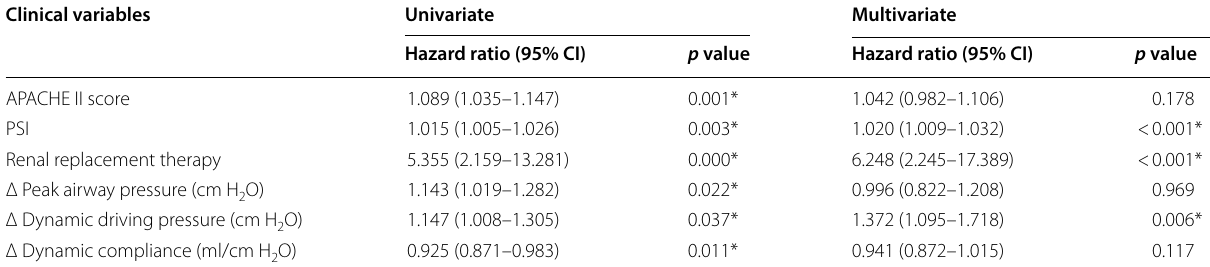
Table 3 Cox regression analysis of clinical variables associated with 60-day mortality in influenza pneumonia-related ARDS with prone